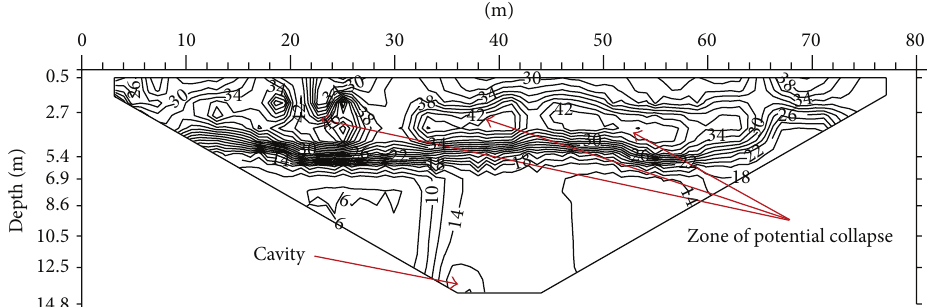
Figure 11: Investigation of 2D porosity image of third